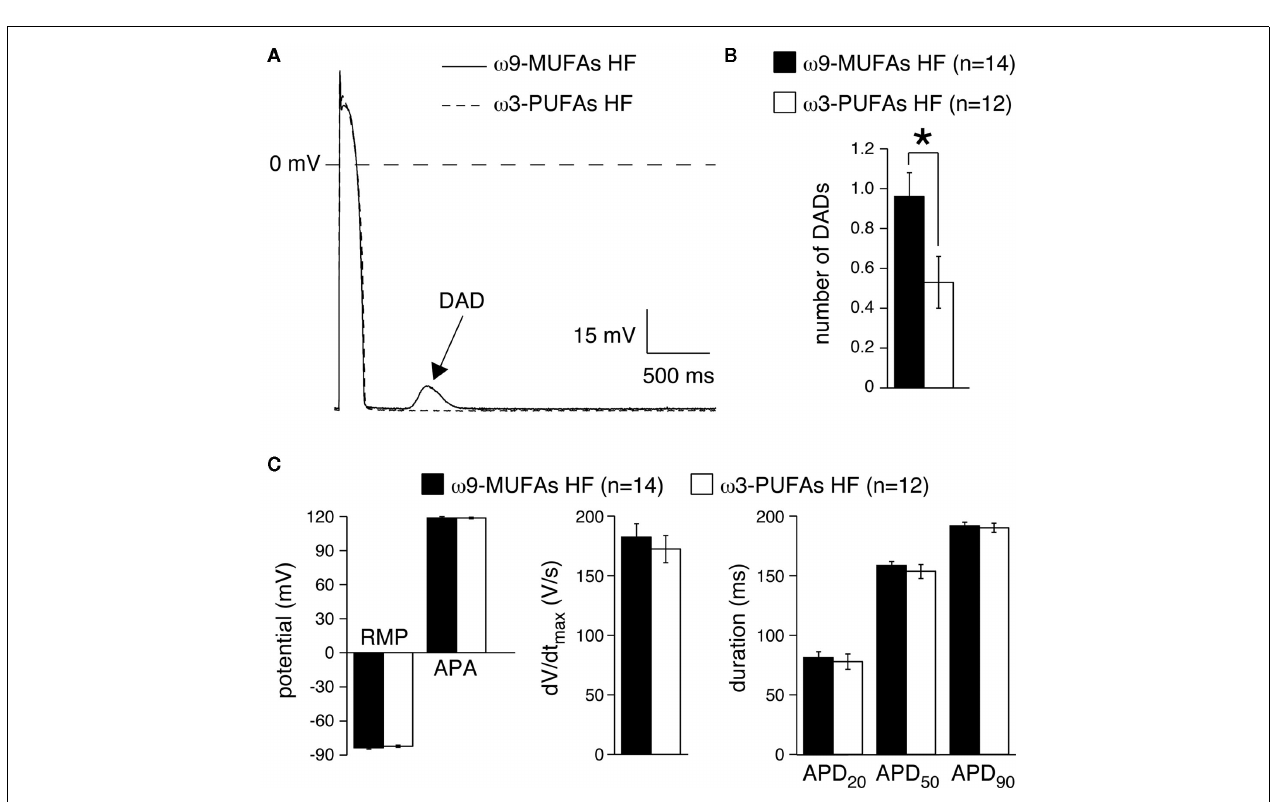
FIGURE 5 | (A) Typical examples of action potentials (AP) and delayed afterdepolarizations (DADs, arrow). (B) Average number of DADs, (C) Average AP characteristics. RMP, resting membrane potential; APA,